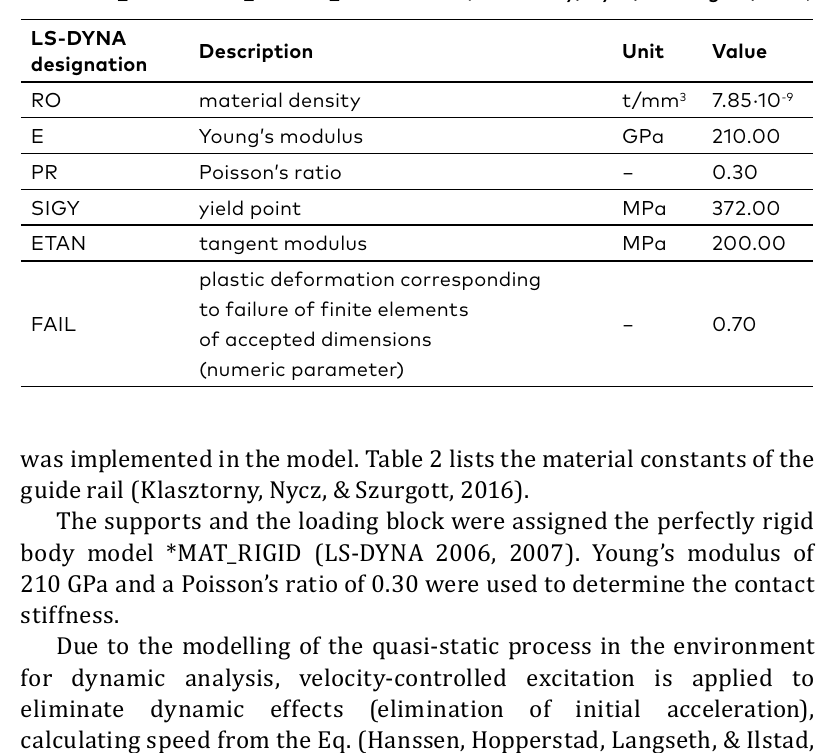
Table 2. Material constants of S235JR steel concerning material